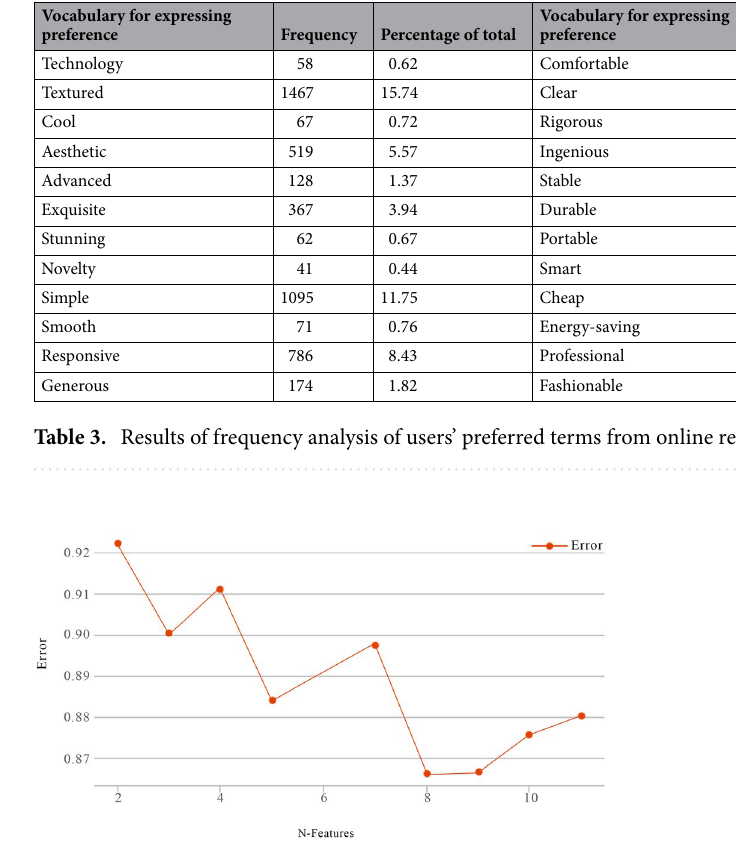
Figure 2. SSE folding line chart.